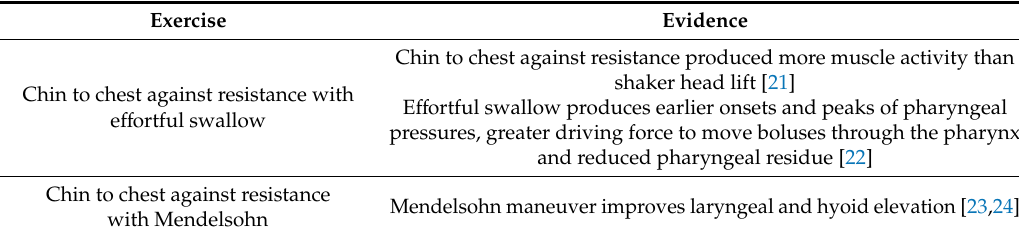
Table 2. Swallow exercises with supporting evidence for their selection (table adapted from